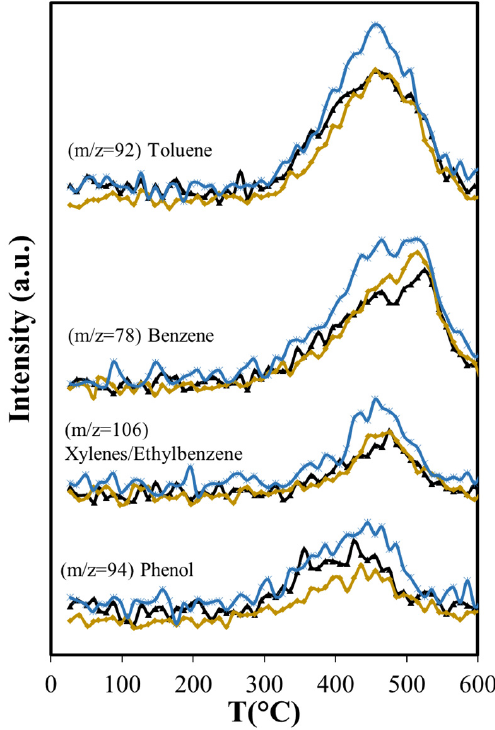
Figure 11. Effects of Aerosil 380 silica and MCM-41 over aromatic compounds produced in catalytic pyrolysis of Agave salmiana bagasse. ( ASB, Aerosil 380, MCM-41).